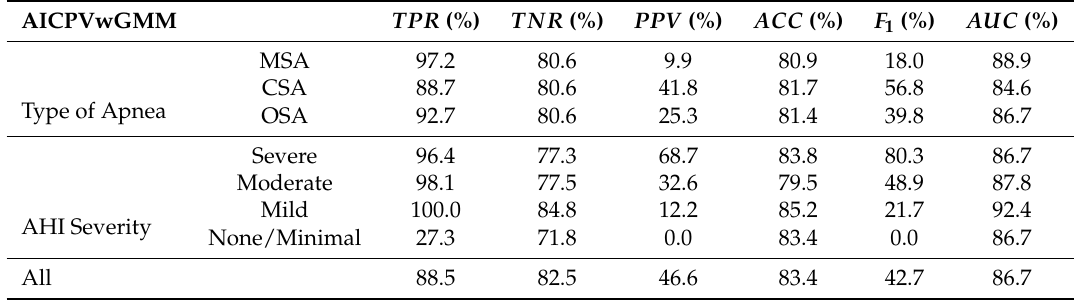
Table 4. Test performance of AICPV with GMM classifier over different types of apnea and different apnea